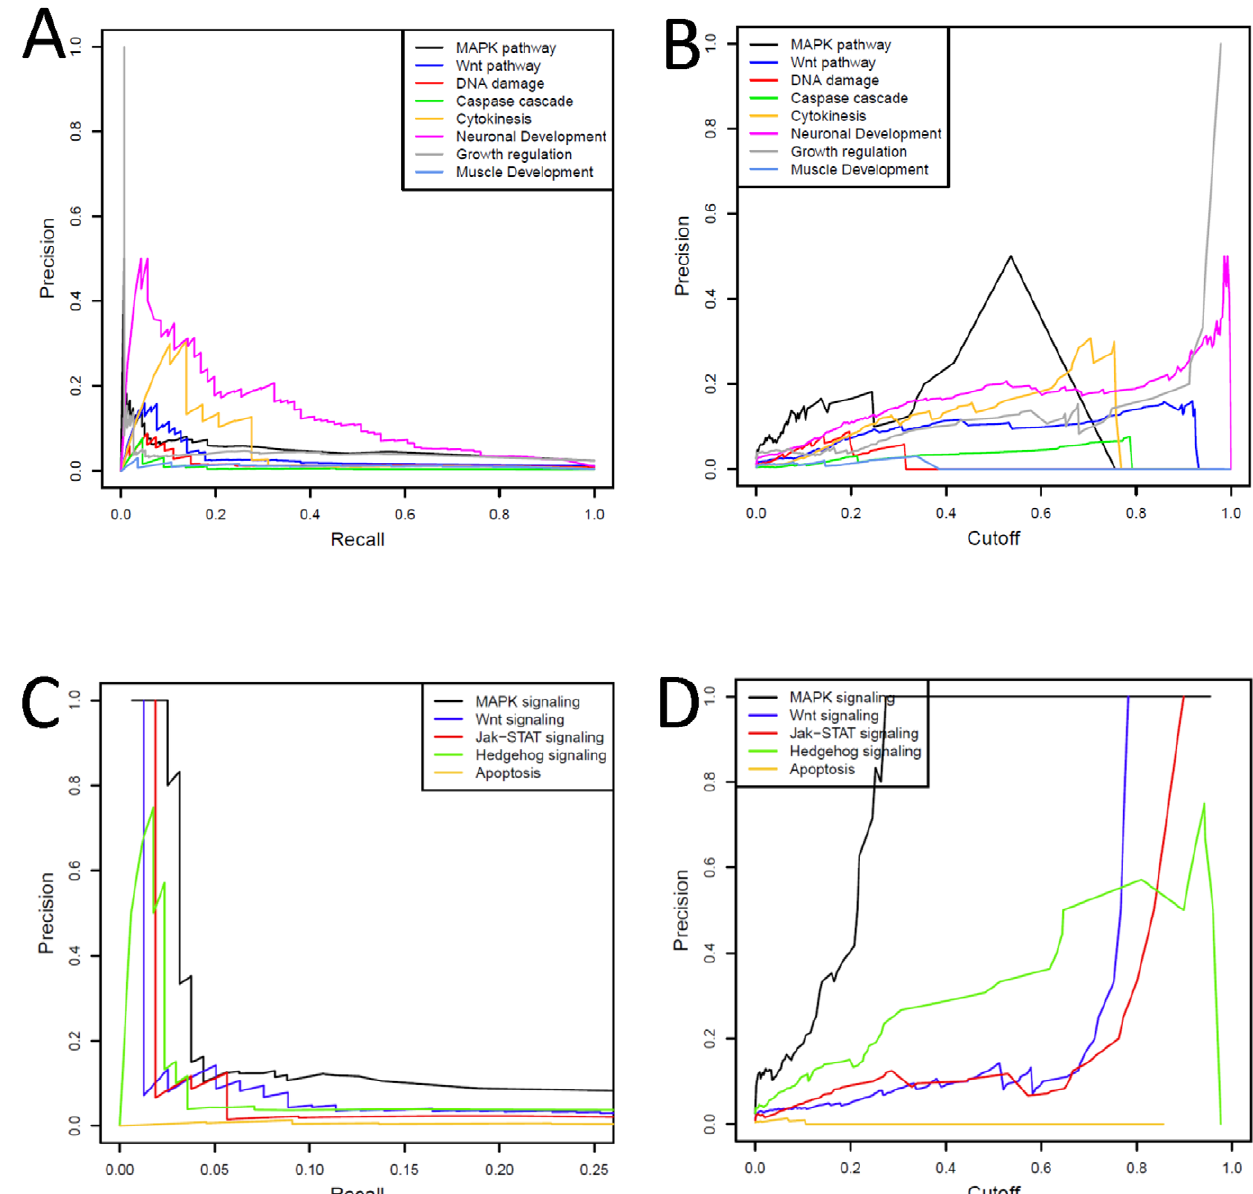
Figure 4. Assessing prediction quality against RNAi screening results. Precision-Recall curves ( A ) and the curves for precision vs. confidence score threshold ( B ) for the quality of GO term prediction measured by DRSC RNAi screening results; Precision-Recall curves ( C ) and the curves for precision vs. confidence score threshold ( D ) for the quality of KEGG pathway membership prediction measured by DRSC RNAi screening results.